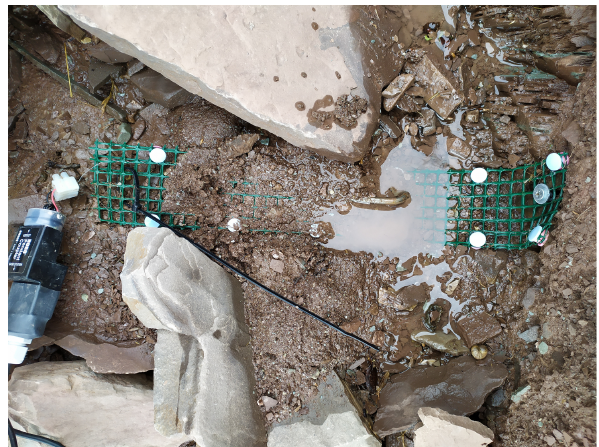
Figure B1. Sensor S 39 covered by